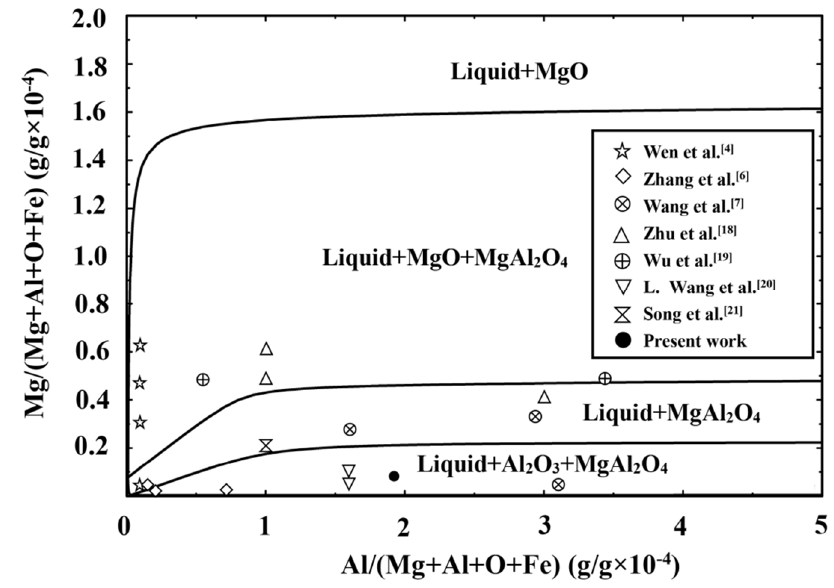
Figure 6. Stable structure phases of Mg ‐ Al ‐ O ‐ Fe formation at 1873 K.